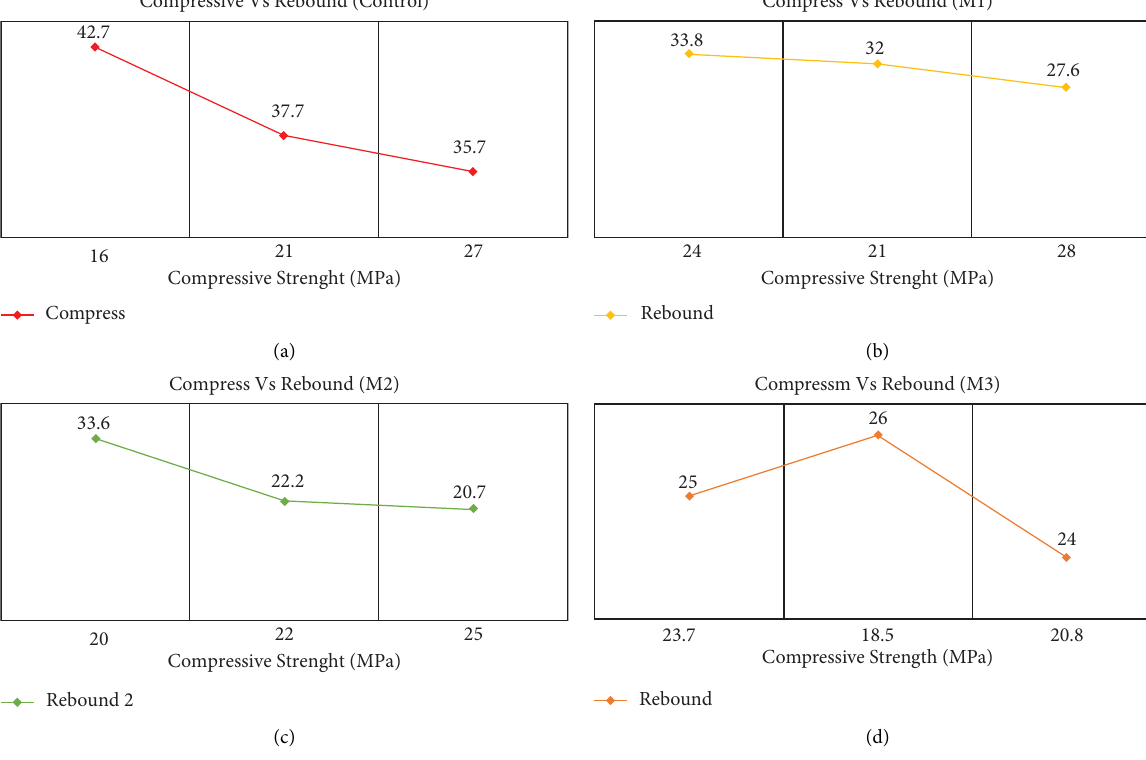
Figure 13: (a–d) Relationship between concrete cube compressive strength and rebound hammer.